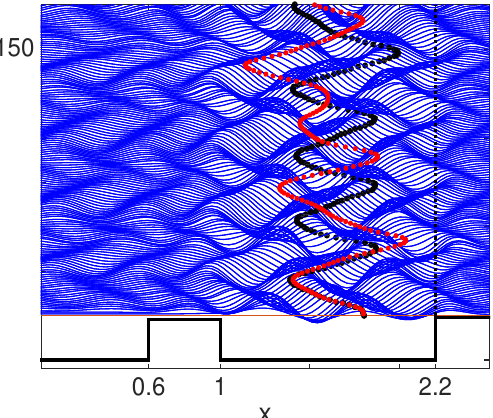
Figure 7. The droplet dynamics are now viewed for two different heights of the left-most barrier, which is not depicted here. The right barrier is kept unchanged with a fluid depth of 0.04 cm above it. In black, and displayed in the background, is the case for a fluid depth of 0.02 cm above the barrier on the left. In red, displayed in the foreground, is the case where both barriers are lower with a fluid depth of 0.04 cm above them. The more complex droplet oscillation is due to an additional distant forcing arising due to wave transmission reaching the left-most cavity. The wave activity in the left cavity affects the droplet, far away in the right cavity.